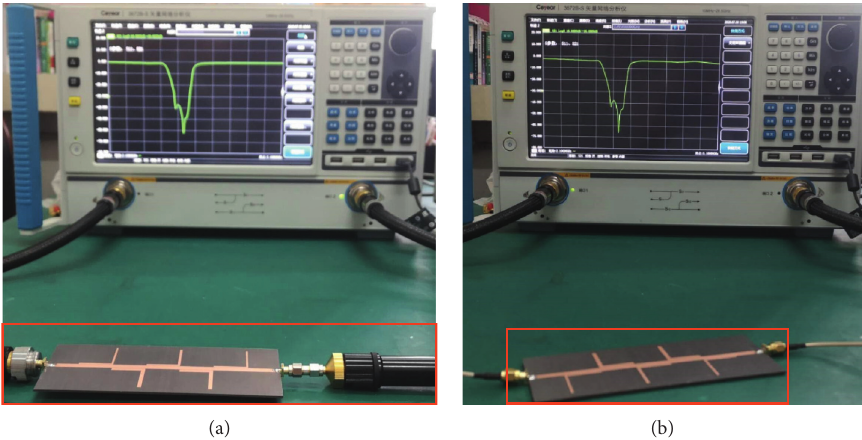
Figure 12: The photograph of experimental equipment for measuring insertion loss: (a) without power line; (b) with power line.